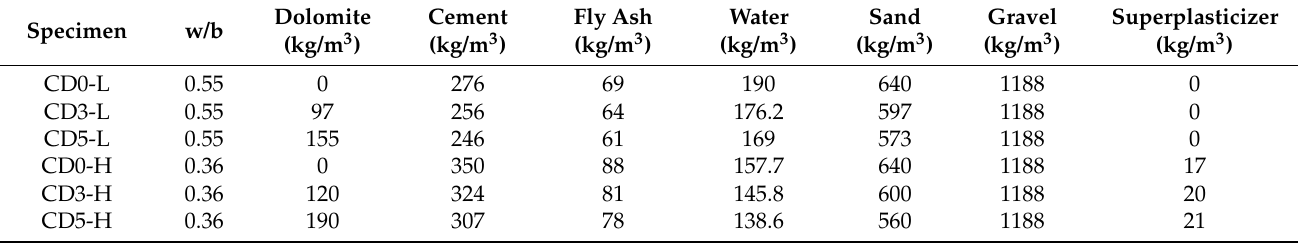
Table 5. Mix proportions of concretes-the amount of ingredients in concrete of per cubic